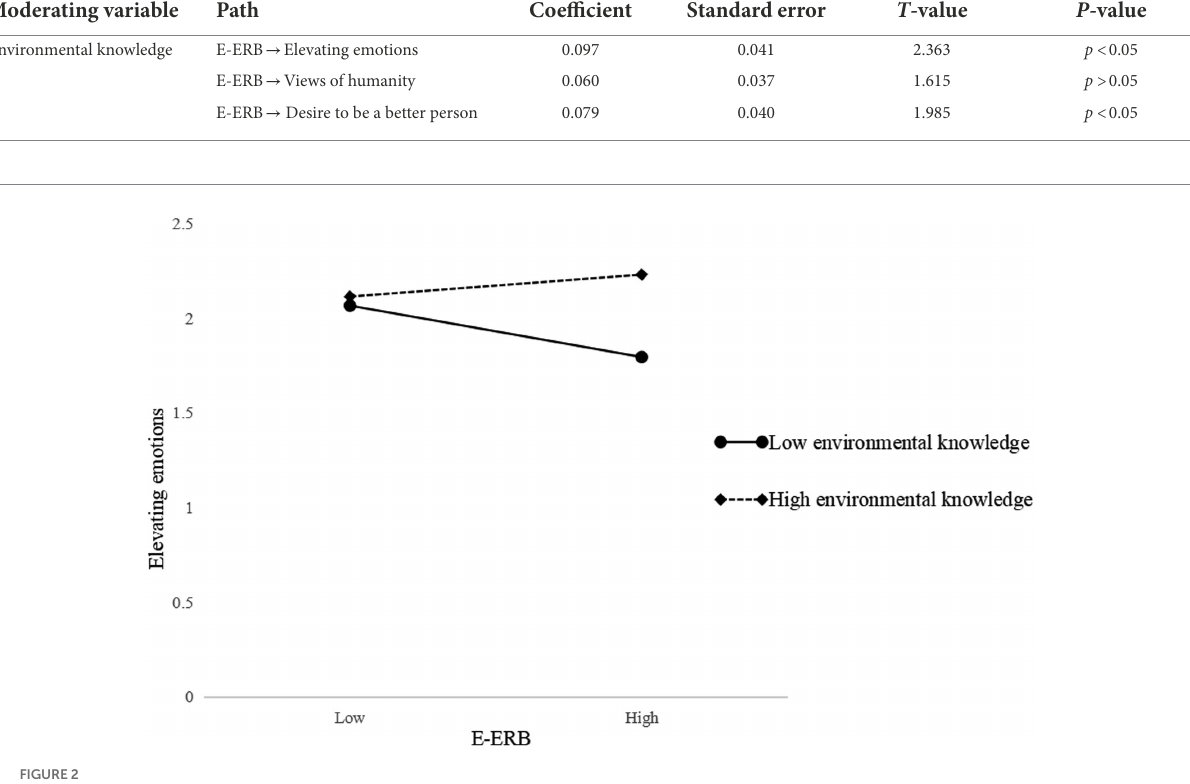
FIGURE 2 Interactive effects of E-ERB and environmental knowledge on elevating emotions.